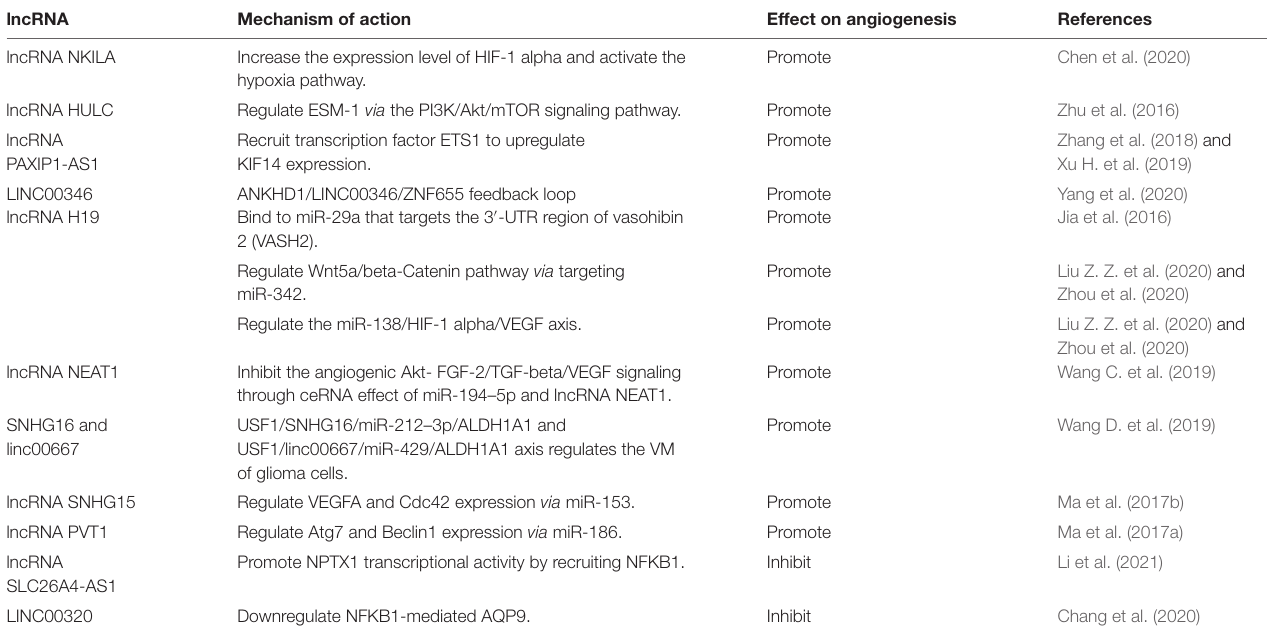
TABLE 2 | lncRNAs involved in the regulation of glioma angiogenesis. lncRNA Mechanism of action Effect on